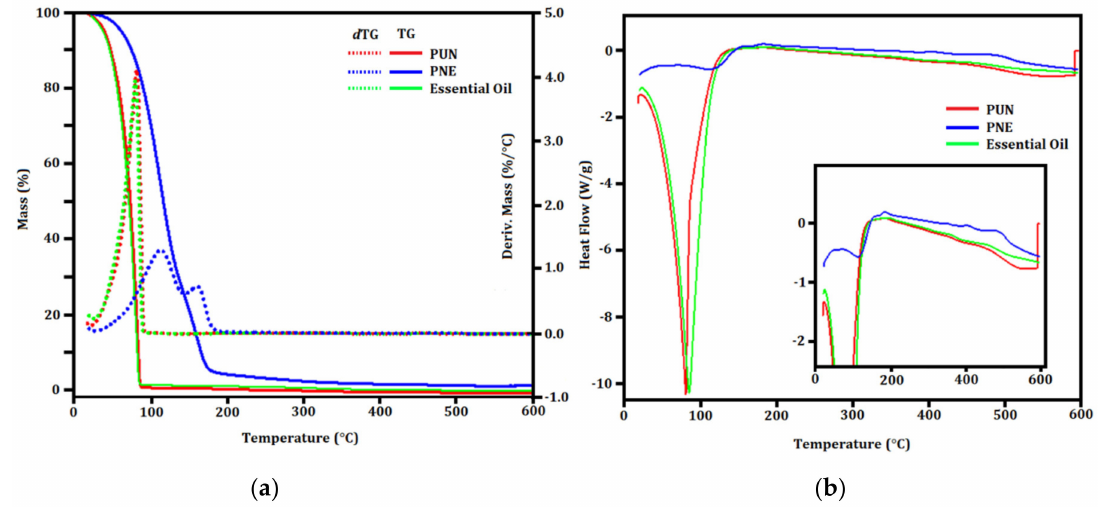
Figure 6. ( a ) TG/ d TG and ( b ) DSC curves of the biodefensives PUN, NPE and in natura essential oil.